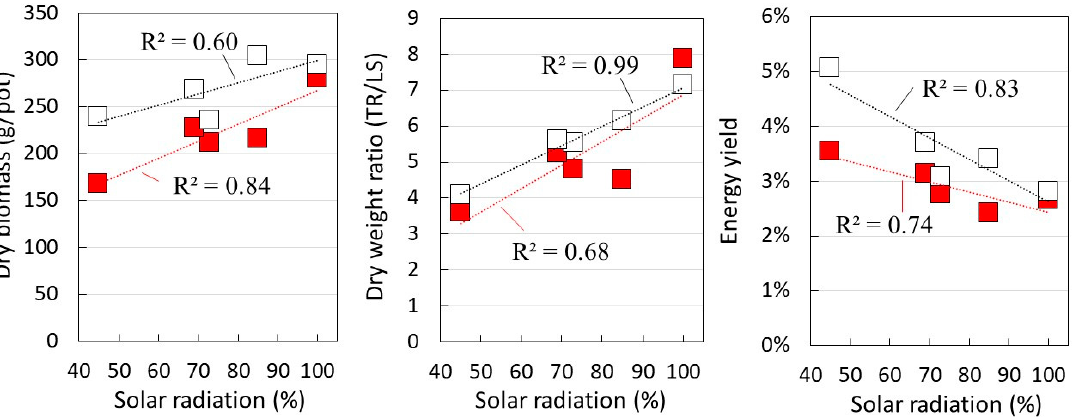
Figure 3. Dry biomass weight per pot, the dry weight ratio of tuberous roots (TR) to leaves and stems (LS), and energy yield, in each solar radiation rate. Symbols: □ ; Suikenkintoki , ■ ; Beniharuka . The data are the mean values, the dotted lines are the approximate lines determined by the least-squares method, and R 2 is the coefficient of determination of the approximate line, indicating the degree of correlation between each element.